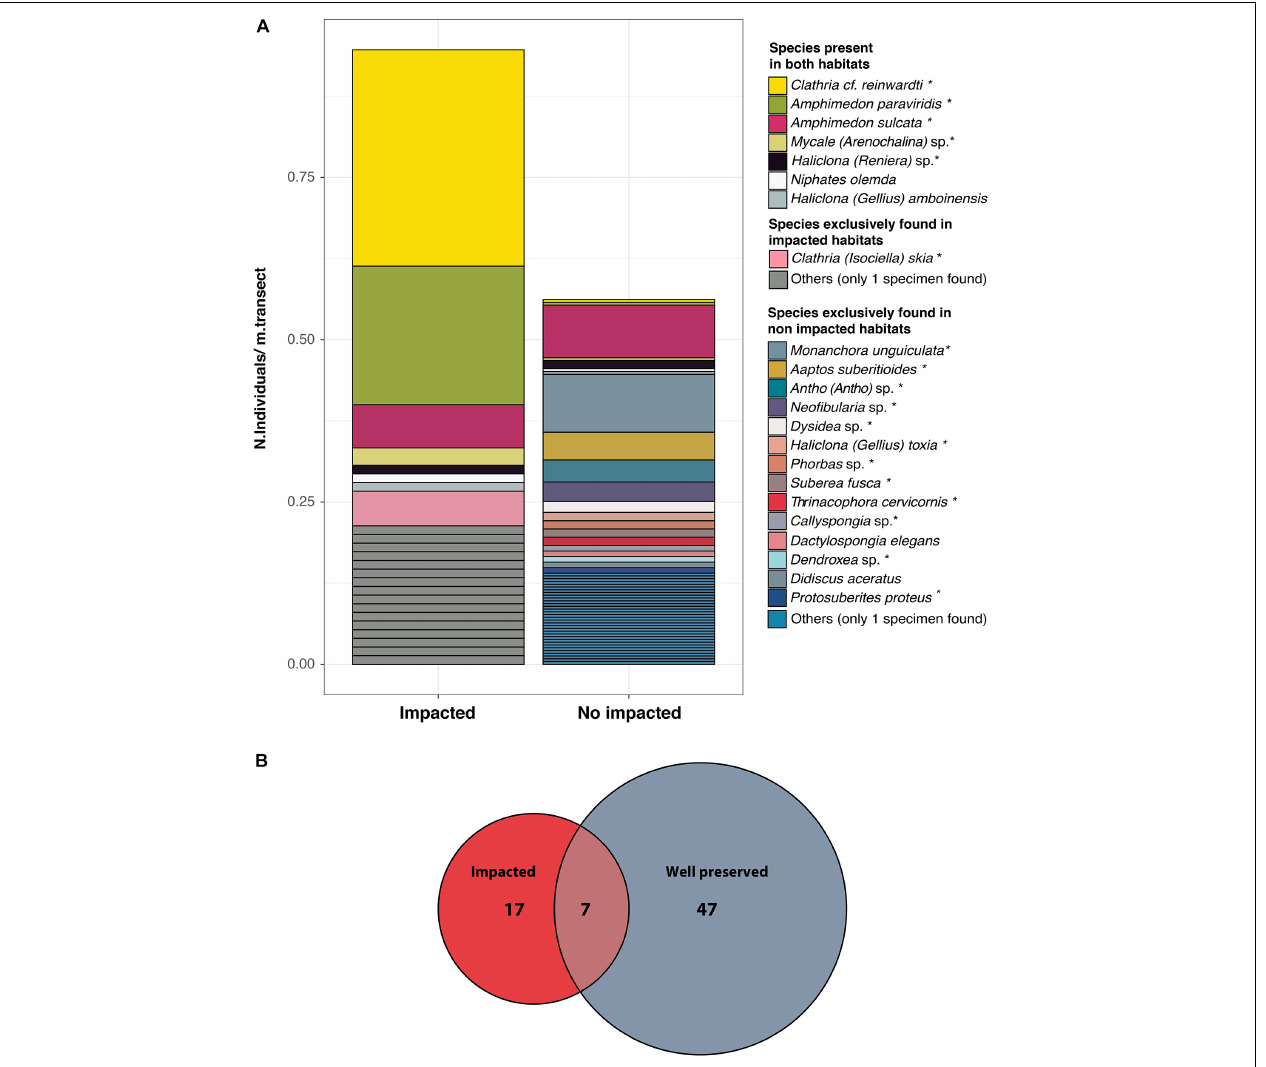
FIGURE 1 | (A) Bar plots of sponge species composition and abundance at the well-preserved and impacted habitats. Y -axis represents the numbers of individuals per meter of transect. (B) Venn diagram of total species richness and the species overlap between well-preserved (gray) and impacted (red) environments. ∗ Indicates species for which microbiome has been